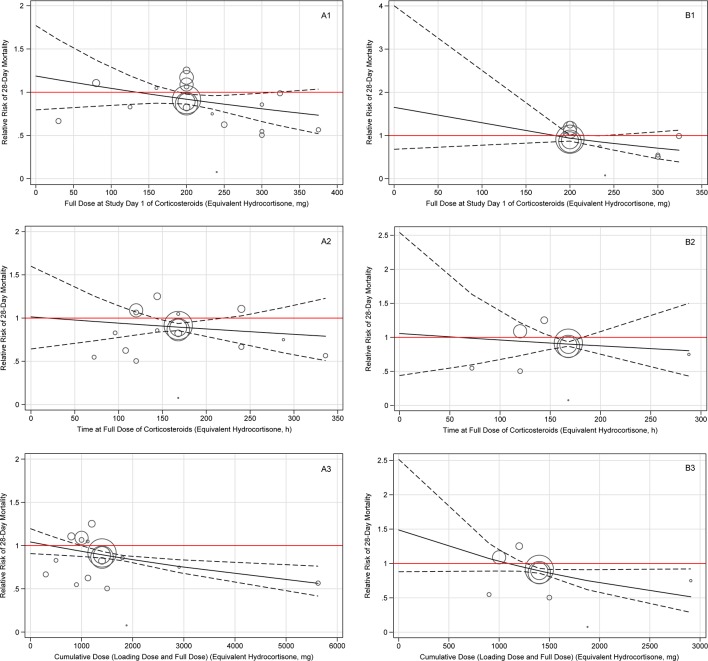
Dose-response of long course of low-dose corticosteroids for 28-day mortality amongst patients with overall patient (A) and septic shock alone patient (B). Note: Plate A indicates the overall patient, and plate B indicates the septic shock alone patient. Each plate contains three dose-response relationships, which are the benefits and harms of 28-day mortality and long course of low-dose corticosteroids dose/duration, including full dose at study day 1 (1), time at full dose (2), and cumulative dose (3). The cumulative dose represents the sum of loading dose and full dose. The solid line represents the regression line of the dose-response, and the dashed line represents the 95% confidence interval.